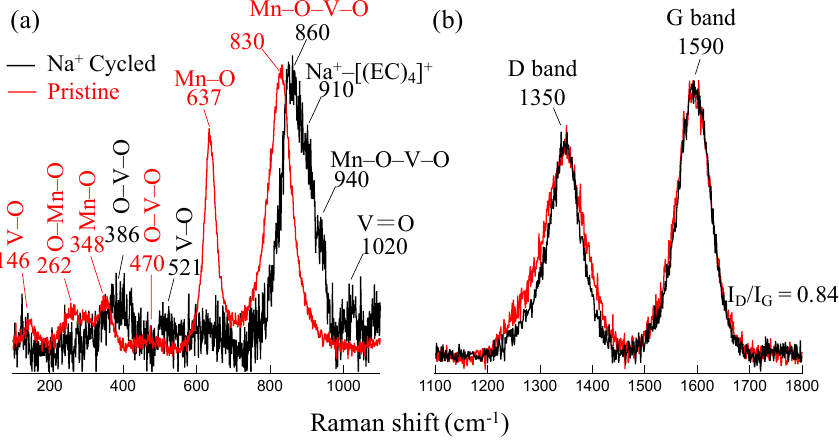
Figure 3. Micro-Raman scattering spectra of pristine and Na + cycled MVO-CNTs electrodes in MVO region ( a ) and carbon bands region ( b ). The Raman spectra were normalized with respect to the highest peak